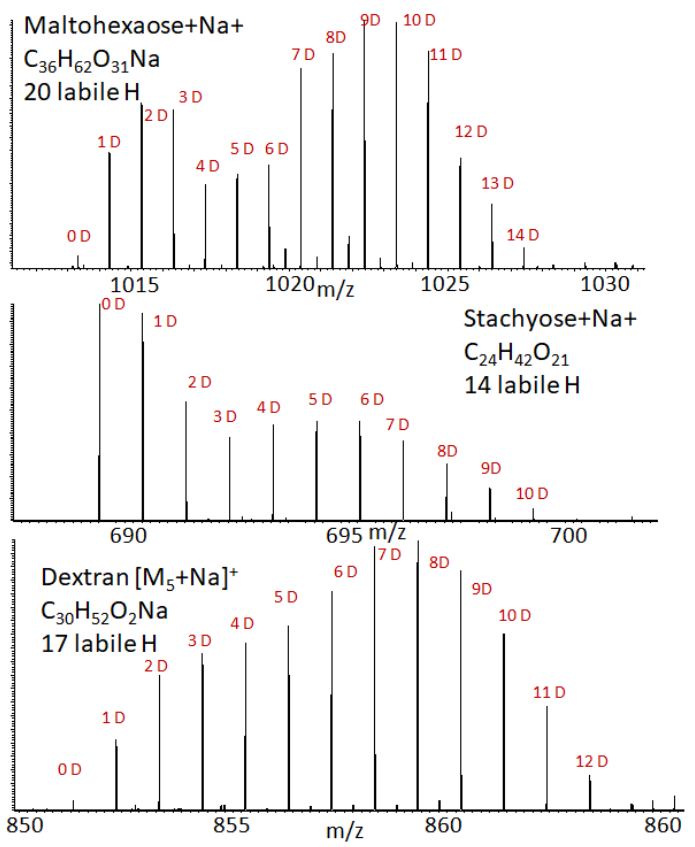
Figure 7. Observation of the bimodal deuterium distribution for selected carbohydrates.